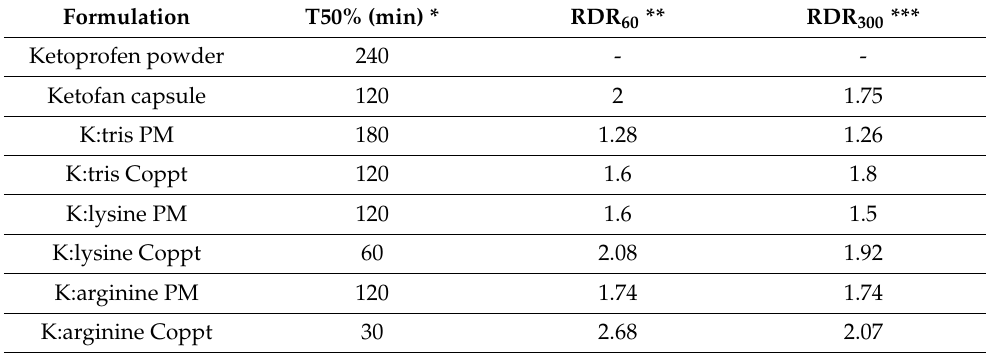
Figure 5. Profiles of in vitro dissolution of ketoprofen powder, commercial capsules, and physical and dispersed mixtures with lysine, arginine, and tris. For the first two hours, simulated gastric fluid (pH = 1.2) was employed, and for the remaining three hours, simulated intestinal fluid (pH = 6.8) was used. Table 2. Dissolution parameters were measured for ketoprofen, commercial capsules, and ketoprofen with respect to excipient mixtures. * T50% denotes the time required for 50% of the initial amount to be dissolved; ** and *** denote relative dissolution rates of 60 and 300 min, respectively. Formulation T50% (min)